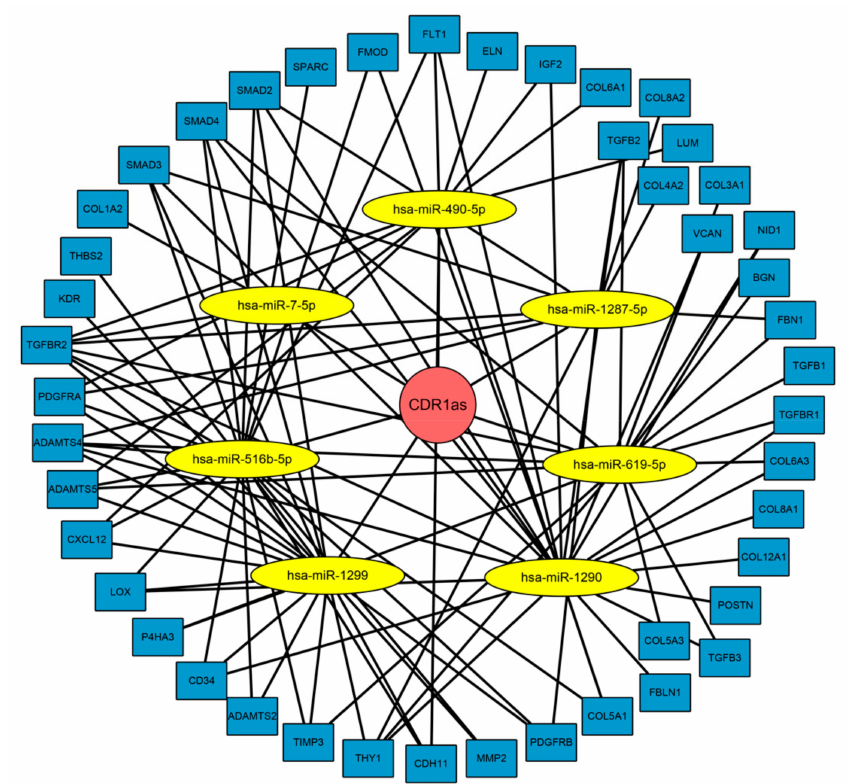
Figure 6. A competing endogenous RNA (ceRNA) network was constructed to illustrate the biological mechanism of CDR1as, which serves as a sponge for multiple miRNAs to relieve silencing for several key genes and regulate the tumor